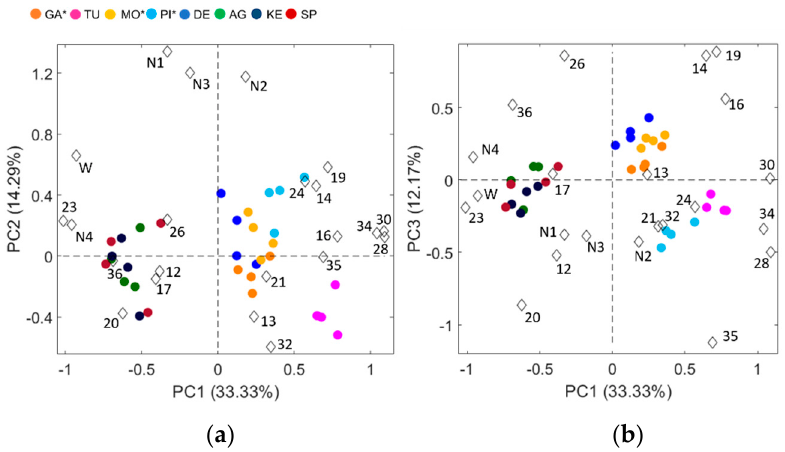
Figure 2. Projection of the potato accessions and morpho-agronomic descriptors onto the ( a ) PC1 – PC2 and ( b ) PC1 – PC3 planes. Asterisks identify the accessions from the Majella National Park. Potato accessions are Gamberale (GA), Turchesa (TU), Montenerodomo (MO), Pizzoferrato (PI), Désirée (DE), Agria (AG), Kennebec (KE), and Spunta (SP). PC: Principal Component.